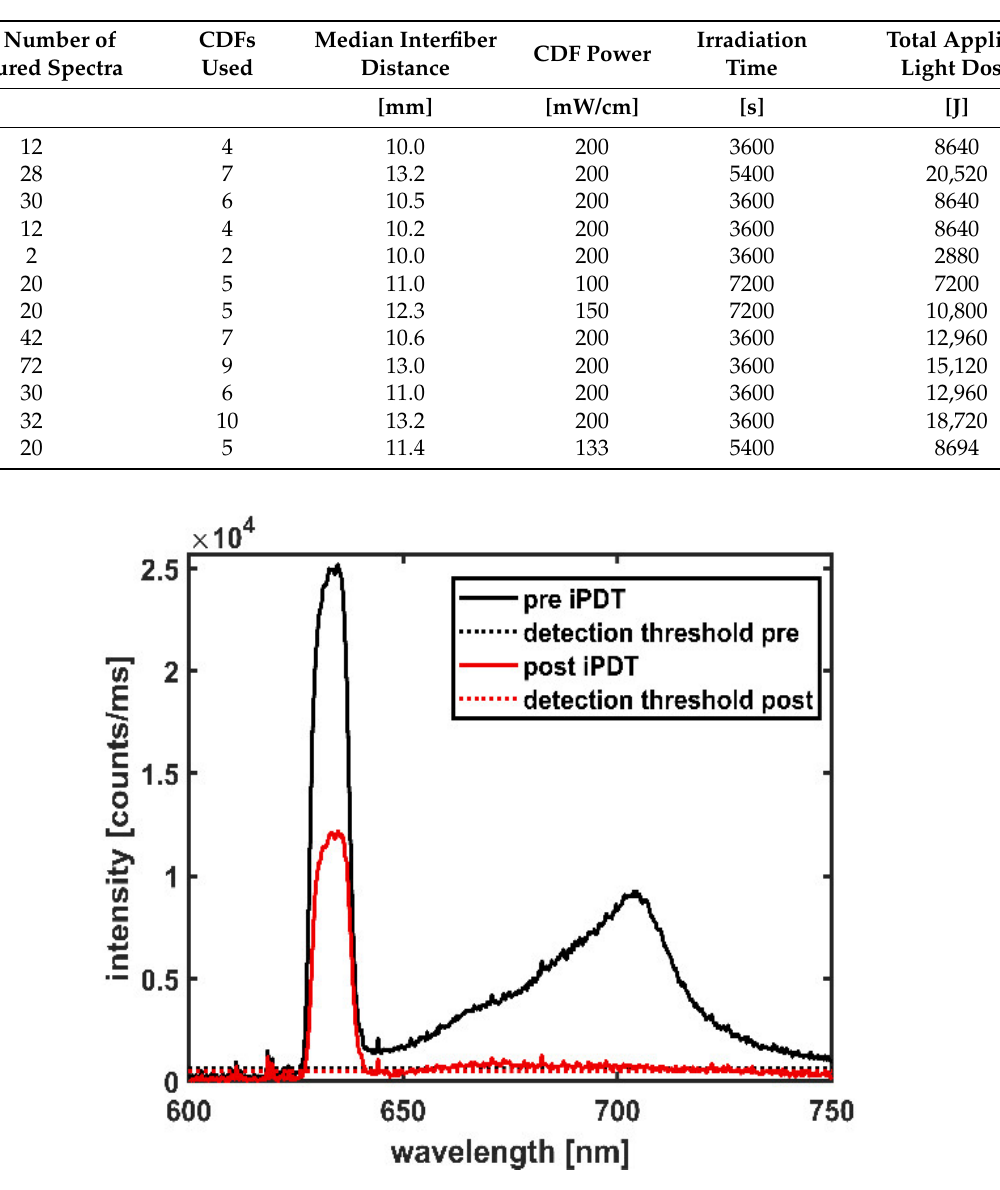
transmitted treatment light is visible in the wavelength range of 626–642 nm. The PpIX fluorescence signal is in the range of 650–750 nm. In total, 320 spectra (pre plus post iPDT) were recorded and analyzed (range: 2–36 per iPDT case, median: 24), representing about 41% of all possibilities of measurable spectra (784 for 392 CDF-pair combinations). Table 1. Irradiation and spectral online monitoring characteristics, displaying the number of mea- sured spectra and used cylindrical diffuser fibers (CDFs) with the irradiation parameters during the treatment.